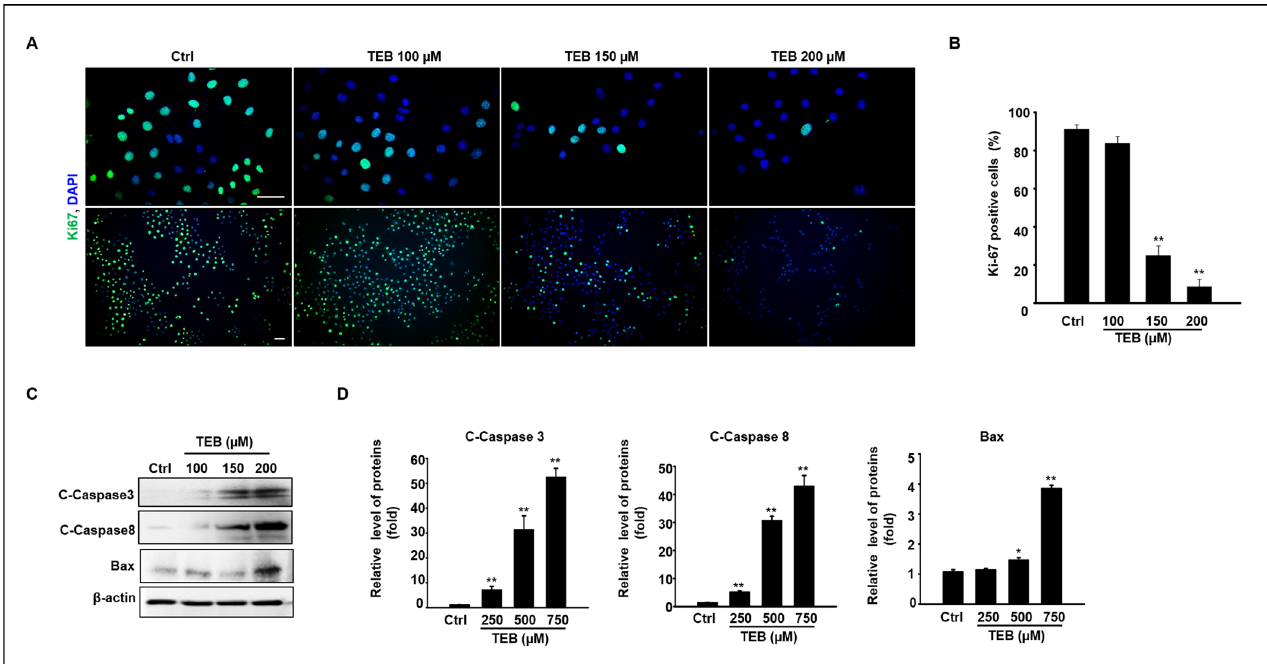
Figure 2. The effects of TE B on MAC-T cell proliferation and pro-apoptotic protein expression. ( A ) Immunofluorescence analysis of Ki -67 in MAC-T cells after culture with 0–200 µm TEB. Scale bar = 50 µm. ( B ) Quantification of Ki -67-positive cells (Green) with respect to total cells (Blue) (%). Data are presented as mean ± SD (n = 4, ** p < 0.001). ( C ) MAC-T cells were treated with the 0–200 µM TEB for 24 h, and then total protein was prepared and analyzed by immunoblotting. The protein expression levels of cleaved caspases 3 and 8, BAX, and β -actin in each experimental group. ( D ) The graph shows the densitometry analysis of protein bands normalized to β -actin. Data are presented as the mean ± SD (n = 4, * p < 0.01, ** p < 0.001).